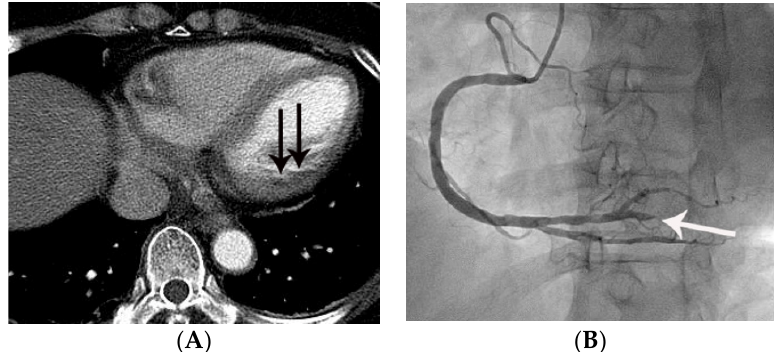
Figure 4. False negative diagnosis of acute myocardial infarction on non-gated chest CT in a 67-year-old female with a small acute myocardial infarction. ( A ) Equivocal MPD (CT score of 1 for myocardial perfusion defect (MPD)) (arrow) was noted in the basal lateral segment of the left ventricle on an axial image. ( B ) Subsequent coronary angiography showed total occlusion (arrow) of the posterolateral branch of the right coronary artery, suggesting a culprit lesion. Note that it was difficult to differentiate true MPD from artifacts in this case.